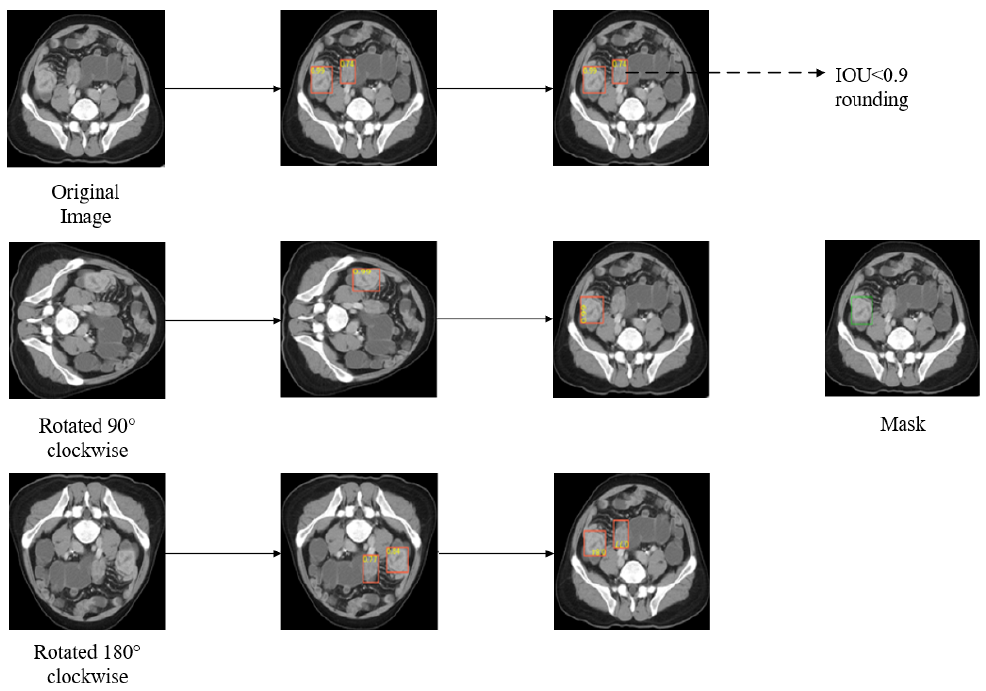
Figure 3. The effect of IOU constraint (the orange bounding box in the figure represents the predicted box, and the green bounding box represents the actual labeled